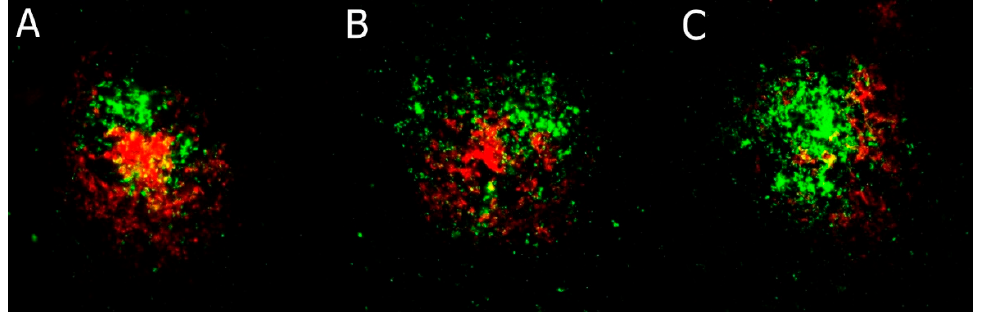
Figure 2. ( A – C ) Immunofluorescence illustration of different patterns of amyloid β (A β ; red) and prion protein (PrP Sc ; green) colocalization in compound plaques in comorbid Alzheimer’s (AD) and Creutzfeldt–Jakob diseases (CJD) cases. Primary antibodies: anti-PrP (rabbit recombinant monoclonal antibody) + anti-amyloid β -protein (mouse monoclonal antibody). The secondary antibody was conjugated with either Alexa Fluor ® 488 (anti-rabbit IgG; green) or Alexa Fluor ® 568 (anti-mouse IgG; red). Scale bar indicates 10 μ m. Images come from the hippocampal region (archicortical parts).